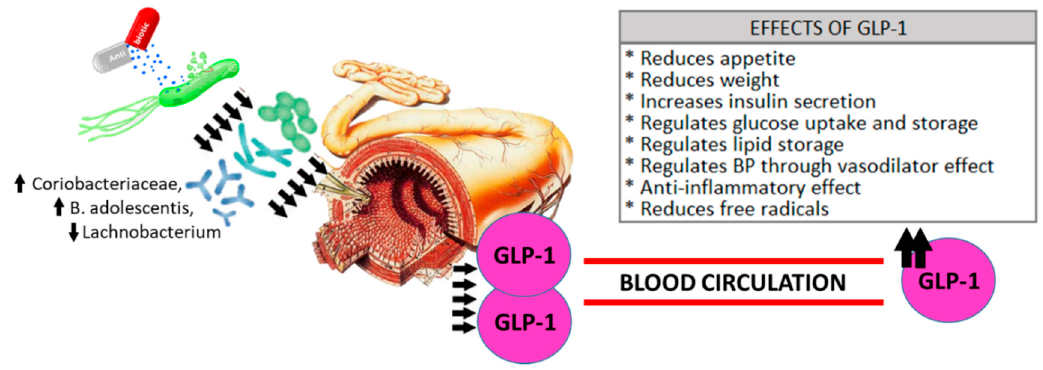
Figure 5. Microbiota and GLP-1 secretion. The use of conventional antibiotic treatment generates modifications in the intestinal microbiota. In this study, these changes in specific microbial communities ( Coriobacteriaceae , B . adolescentis , Lachnobacterium ) have been related with an increase the secretion of GLP-1 and its beneficial effects.